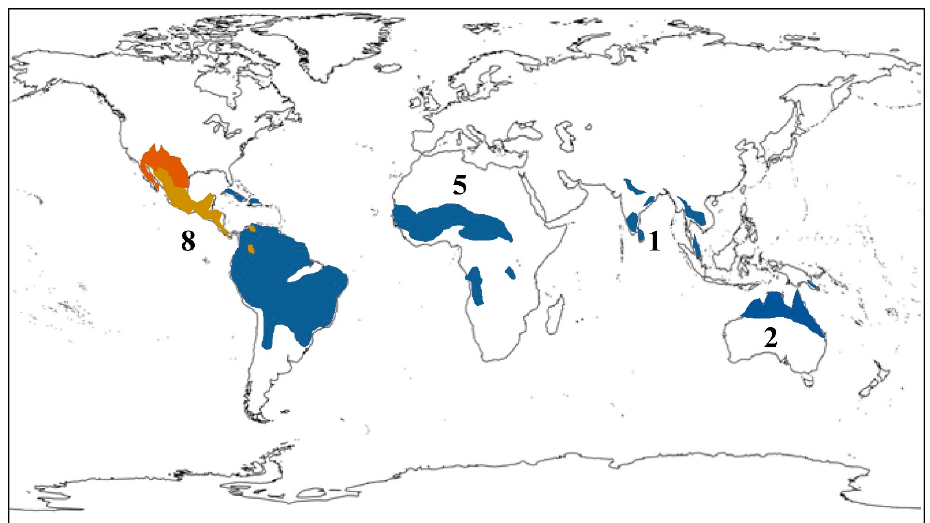
Figure 1. Distribution of the two genera of Cochlospermaceae. Blue = Cochlospermum ; Orange = Amoreuxia ; Yellow = overlapping ranges of the two genera. Numbers indicate the numbers of species in different geographic regions. 8—the Americas; 5—Africa; 1—Asia; 2—Australia.